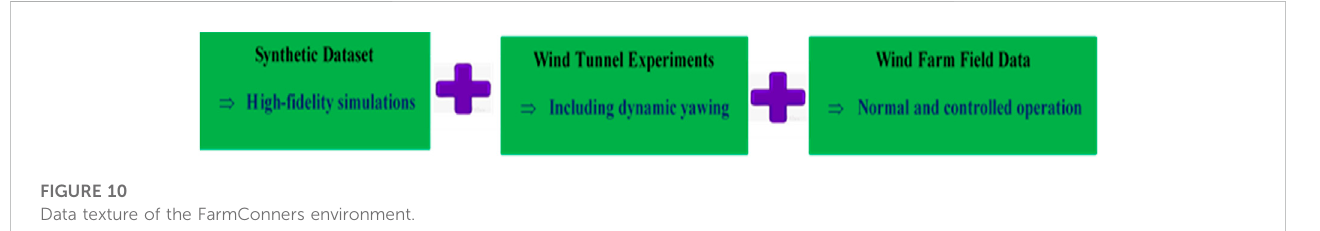
FIGURE 10 Data texture of the FarmConners